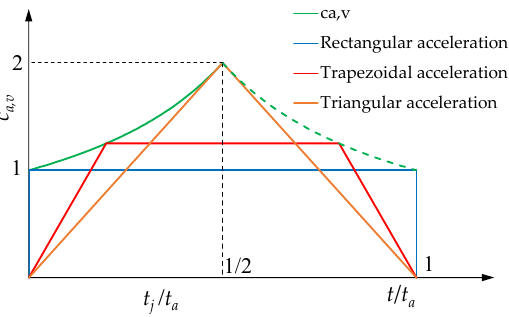
 (cid:95) t and different dimensionless STAPs. c versus Figure 3. Profile of t j and different dimensionless STAPs. Figure 3. Profile of c a , v versus j a,v The jerk is finite unless t j is equal to zero. From Equations (11) and (12), the maximum The jerk is finite unless t is equal to zero. From Equations (11) and (12), the maxi- j value of the jerk is given by mum value of the jerk is given by